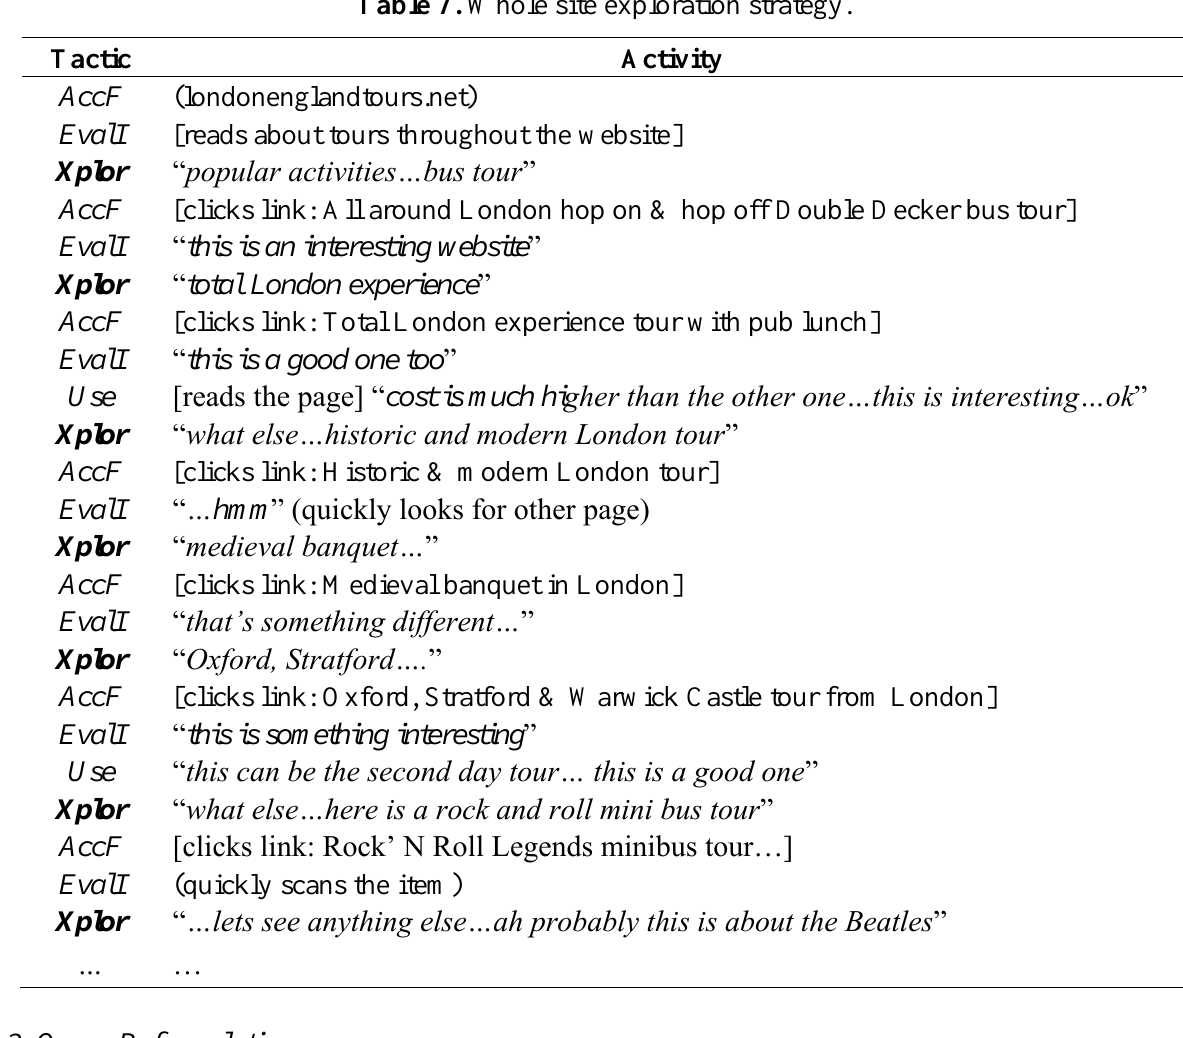
Table 7. Whole site exploration